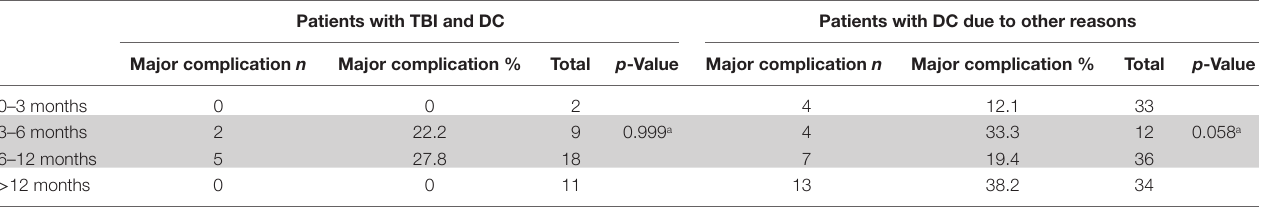
TaBle 3 | Time interval between decompressive craniectomy and cranioplasty and comparison of major complications.